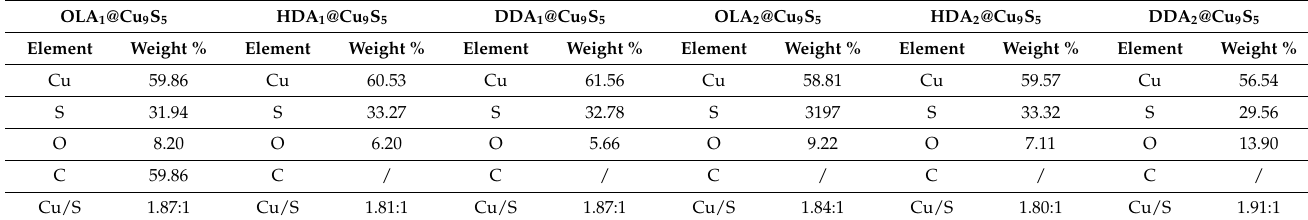
Table 2. EDX analysis of OLA@Cu 9 S 5 , HDA@Cu 9 S 5 , and DDA@Cu 9 S 5 NPs obtained at 230 ◦ C using complex 1 and complex 2.